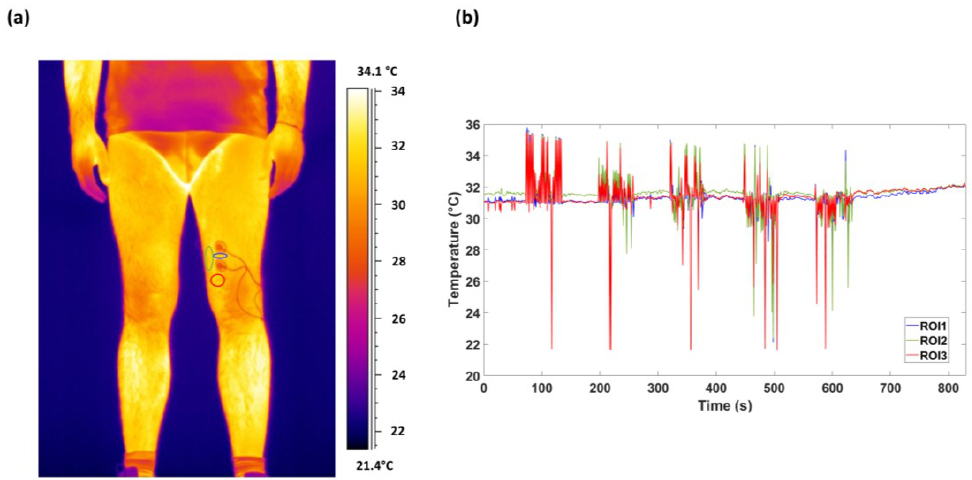
Figure 2. ( a ) A representative participant’s thermogram and ROI placement over the VM. Specifically, the blue, green, and red circles are the ROI1, ROI2, and ROI3, respectively. ( b ) The time course of the average temperature of each ROI during the experiment, obtained through a video tracking algorithm.